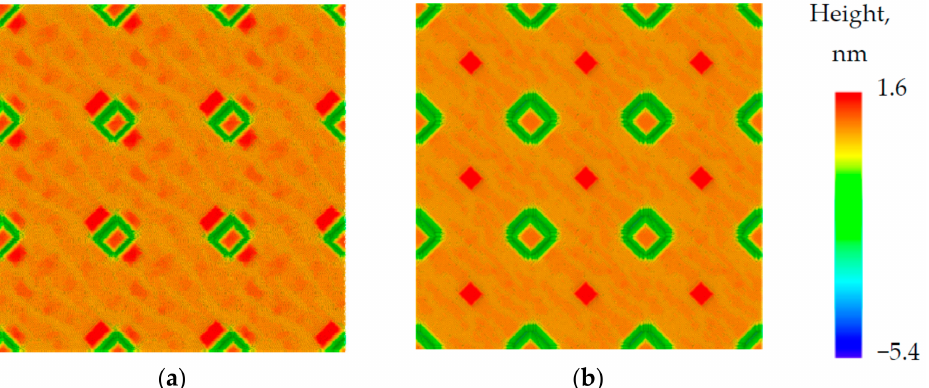
Figure 2. Calculated morphology of the pit-patterned Si(001) substrate with V-shaped pits with different inclination angles of sidewalls ( a ) α = 30 ◦ and ( b ) α = 54 ◦ after deposition of 4 ML and 5 ML of Ge, respectively. The growth temperature is 450 ◦ C. The rate of Ge deposition is 0.1 ML/s. The zero height level in the color legend corresponds to the flat surface level between